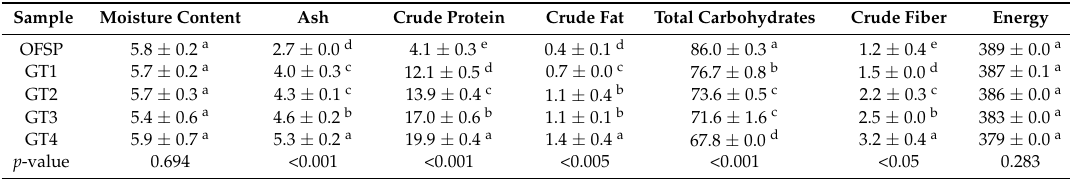
Table 2. Proximate (%) and energy (kcal/100 g) composition of orange fleshed sweet potato-based composite flours on dry weight basis (except moisture